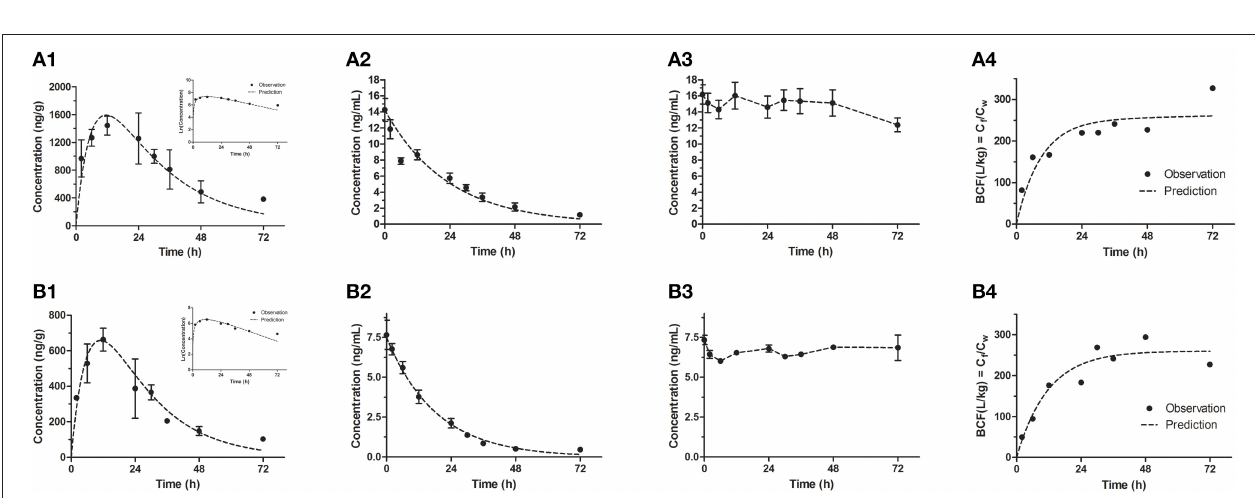
FIGURE 1 | Bioconcentration of emodin in the standard test. (A,C) The concentration-time profiles in eleutheroembryos at high and low level concentrations. (B,D) Emodin concentration of exposure medium at high and low level concentrations.